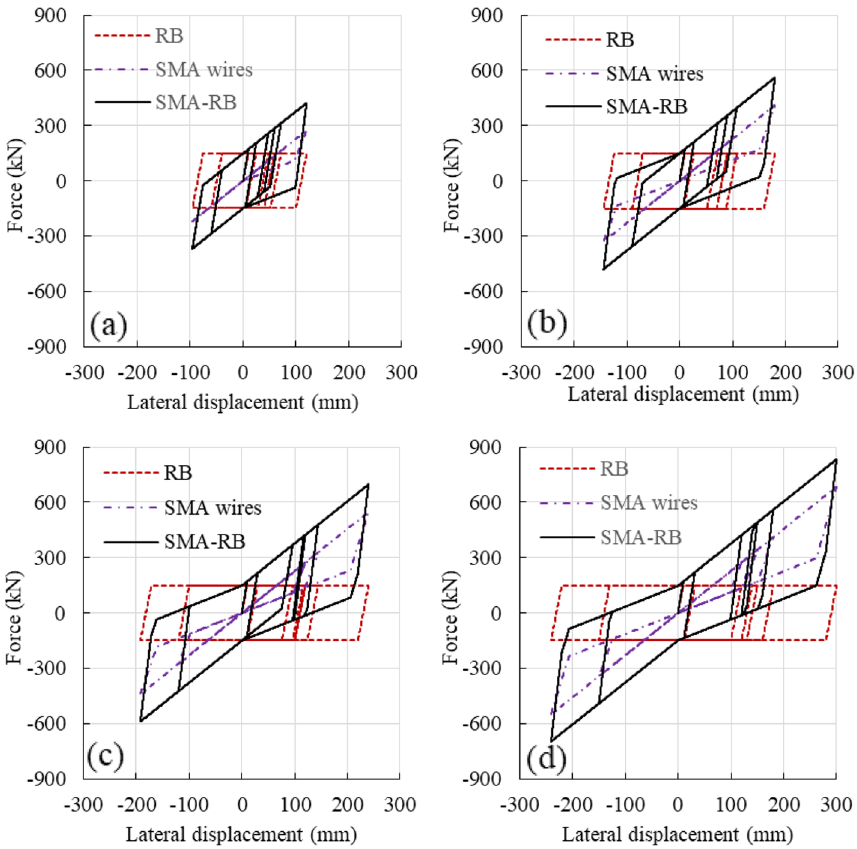
Fig. 10 Typical force displacement responses of SMA-RBs at different damage states ( a ) Slight; ( b ) Moderate; ( c ) Severe; ( d ) Collapse